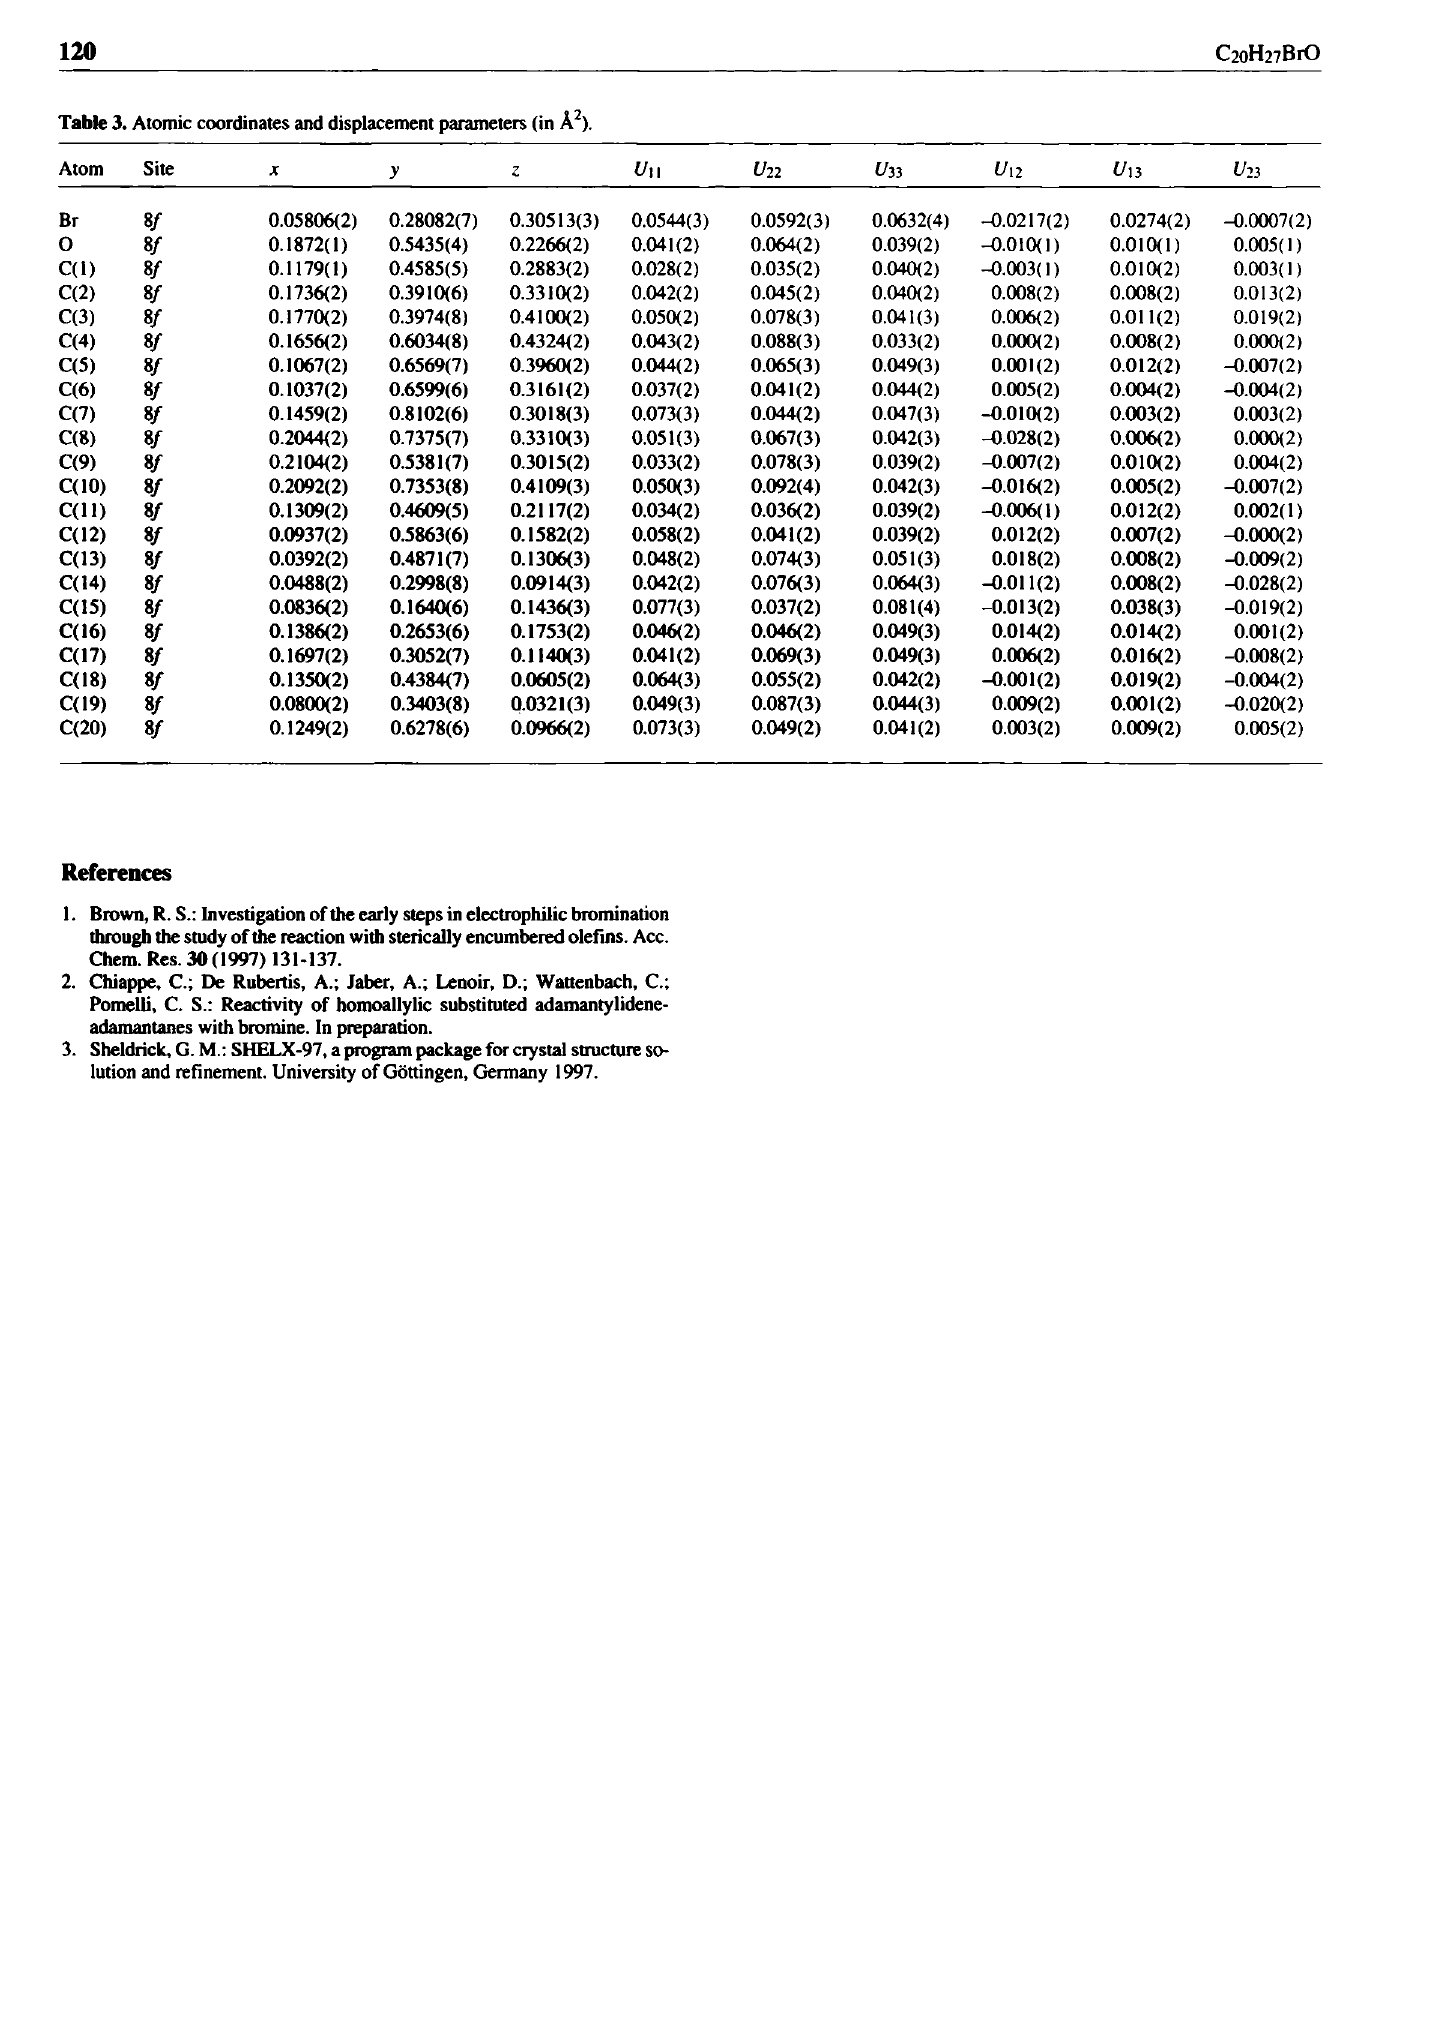
Table 3. Atomic coordinates and displacement parameters (in Â 2